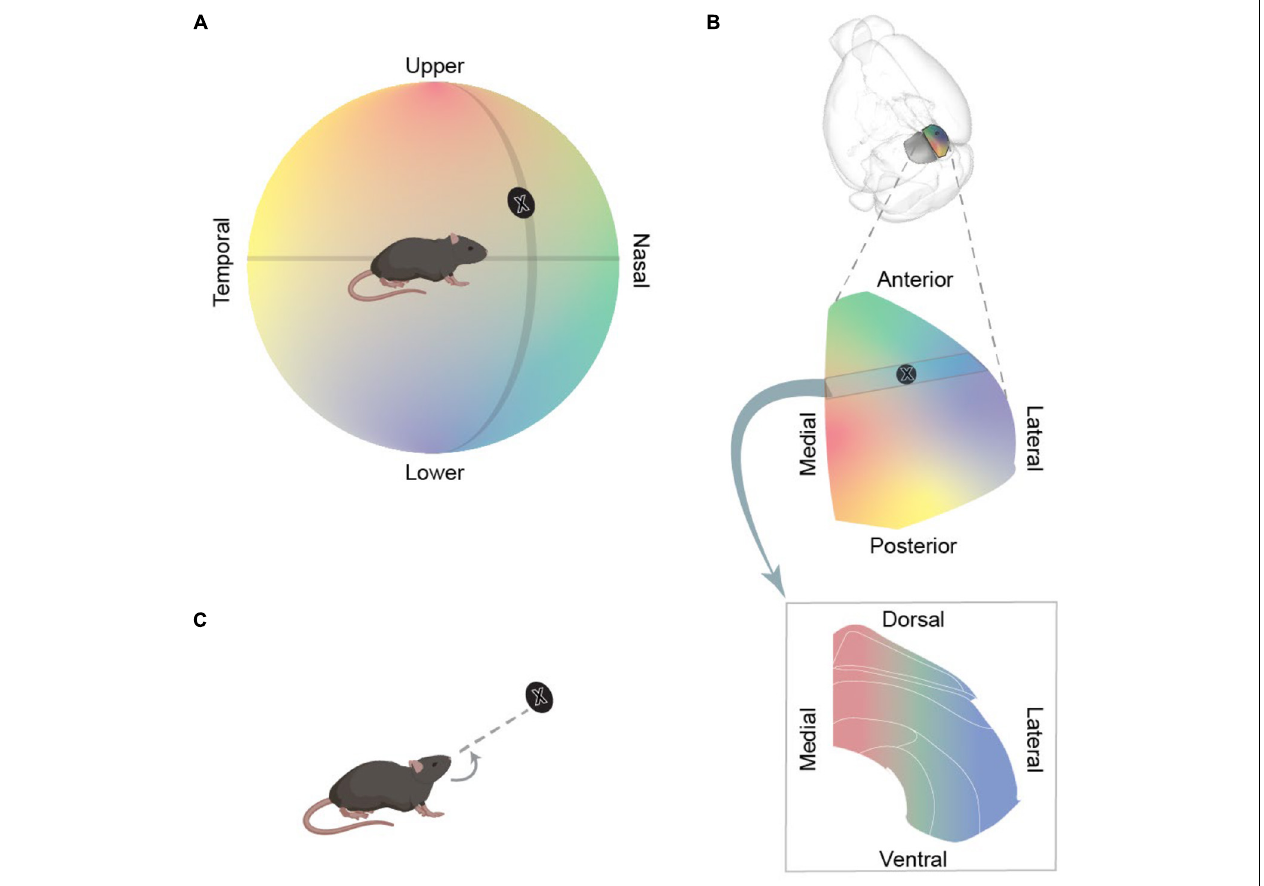
FIGURE 2 | Topographic organisation of SC. (A) Schematic illustrating a mouse, and the world to its left, as mapped onto a hemisphere around the mouse. The direction of objects are defined in terms of visual angle: their azimuth (position along the nasal-temporal axis) and their elevation (position along axis from the upper-lower field). Azimuth and elevation axes are depicted as black lines and the black disc represents an example object. (B) Schematic representation of the mapping of the world onto different sections of SC. Top panel illustrates the position of SC in the mouse brain. Middle panel enlarges the right SC and shows how azimuth and elevation axes of visual field are mapped onto SC. The black disc indicates the approximate location of object in panel (A) in this map. Bottom panel illustrates the mapping of the world onto a coronal section through SC. (C) Activation of intermediate layer would evoke a turn towards the egocentric location represented by that region of